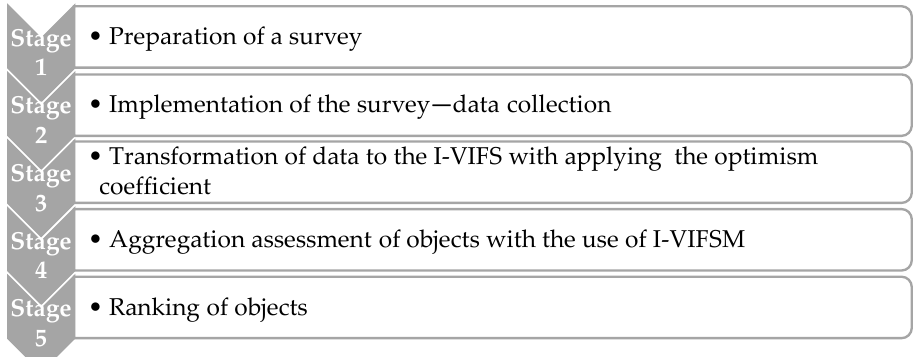
Figure 1. Procedure for the analysis of survey data.